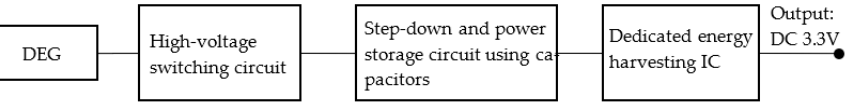
9 of 17 Figure 12. Shunt regulator circuit with TI reference voltage IC (5 V output). (7) Shunt regulator circuit with TI reference voltage IC (2.5 V, 5 V output) The output from the small DEG device was stepped down by a few volts in a circuit using a capacitor, and then converted to a constant voltage using a reference voltage IC (see Figure 13). Figure 13. Shunt regulator circuit with TI reference voltage IC (2.5 V, 5 V output). (8) Circuit using a dedicated energy harvesting IC manufactured by Analog Devices (DC3.3 V) After stepping down the rated input voltage of the energy harvesting-dedicated IC in a circuit using a capacitor, the output from the small DEG device was stored and con- verted to a constant voltage using the energy harvesting-dedicated IC (see Figure 14). Figure 14. Circuit using a dedicated energy harvesting IC manufactured by Analog Devices (DC3.3 V).